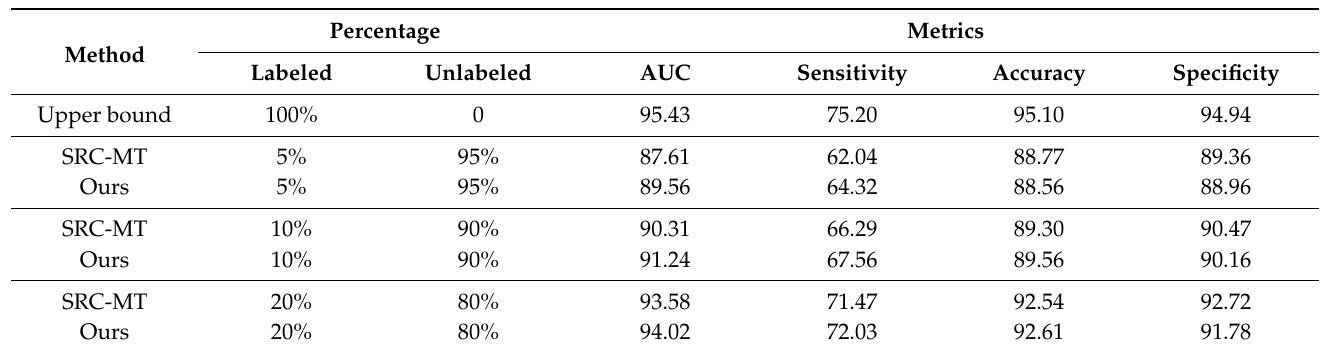
Table 2. Performance comparison of our methods on the ISIC 2018 dataset with different percentages of labeled data.